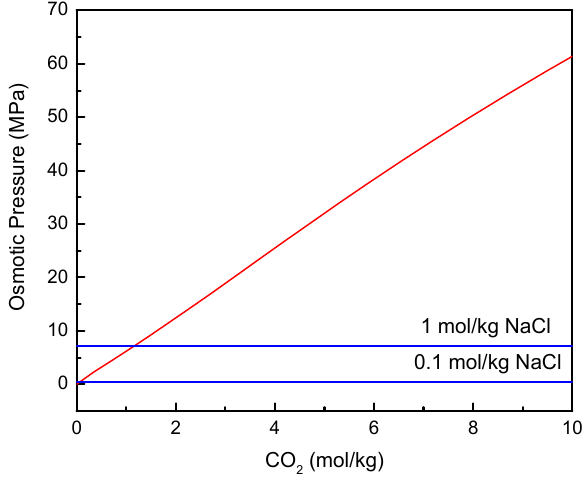
Figure 6. Osmotic pressure of draw solution at difference CO 2 concentrations.